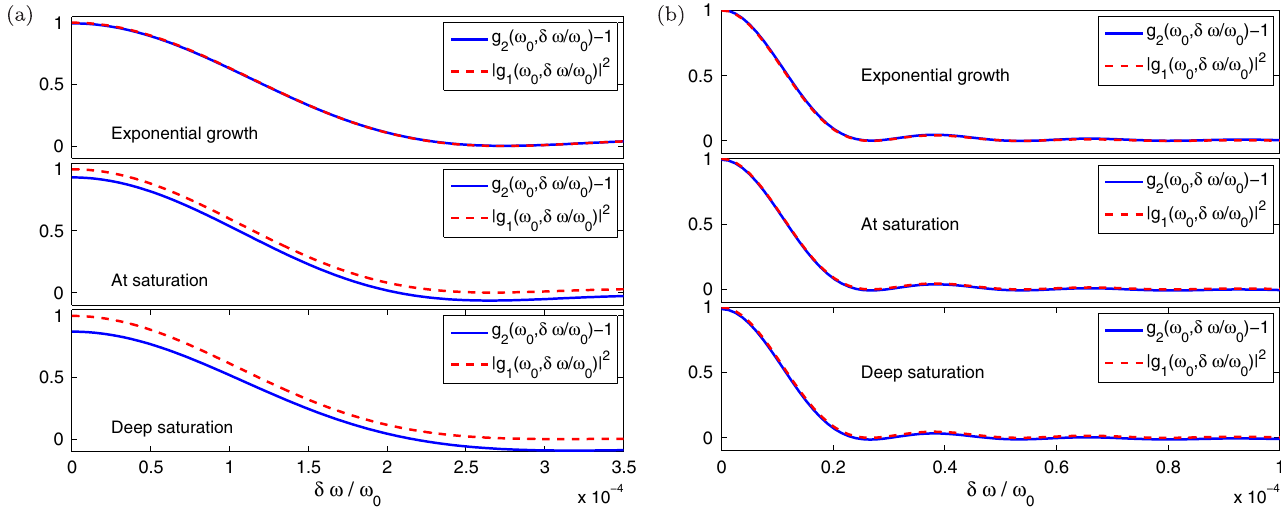
FIG. 6. Equation (10) in the linear regime, at saturation and in deep saturation. g 2 ð ! 0 ; (cid:1)! Þ (cid:1) 1 (solid blue) and j g 1 ð ! 0 ; (cid:1)! Þj 2 (dashed red). (a) Simulated results using an electron bunch 30 (cid:7) m long. (b) Simulation results using an electron bunch 3 (cid:7) m long.